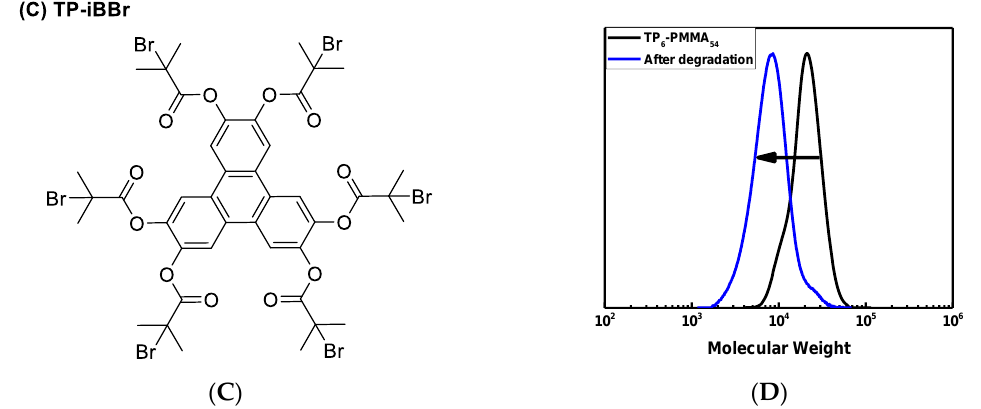
Figure 2. ( A ) The GPC traces of tannic acid-poly(methyl methacrylate) (TA-PMMA) PMMA 25 and ( B ) TA-P(OEO 300 MA) 25 before (black) and after (blue) degradation. Insets in A show the solution color before and after degradation. ( C ) The structure of the TP 6 Br core. ( D ) The GPC traces of TP-PMMA 54 before (black) and after (blue) degradation.